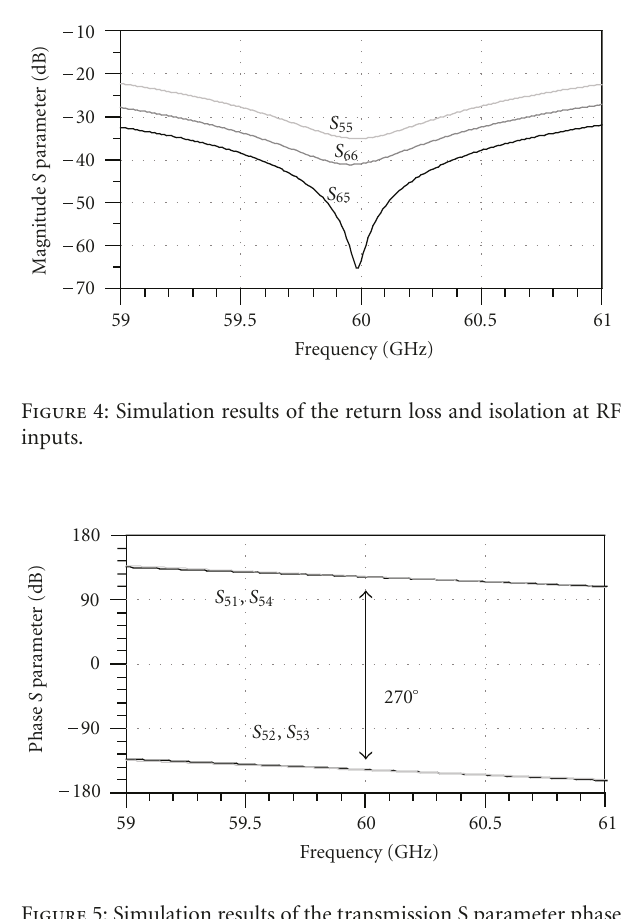
Figure 5: Simulation results of the transmission S parameter phase corresponding to the LO input.